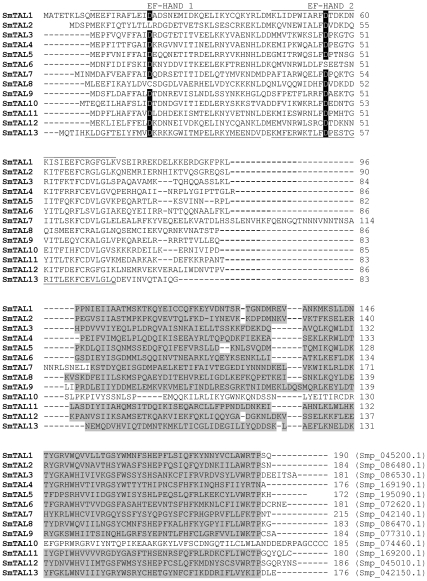
Alignment of amino acids sequences of the SmTAL family.Helix-loop-helix EF-hand domains (Pfam00036) are indicated. The canonical aspartic acid residues at the start of the loop are denoted D on black background. Residues in the dynein light chain domain (EMBL/EBI IPR001372) are shaded grey. Alignment was performed using Clustal W.